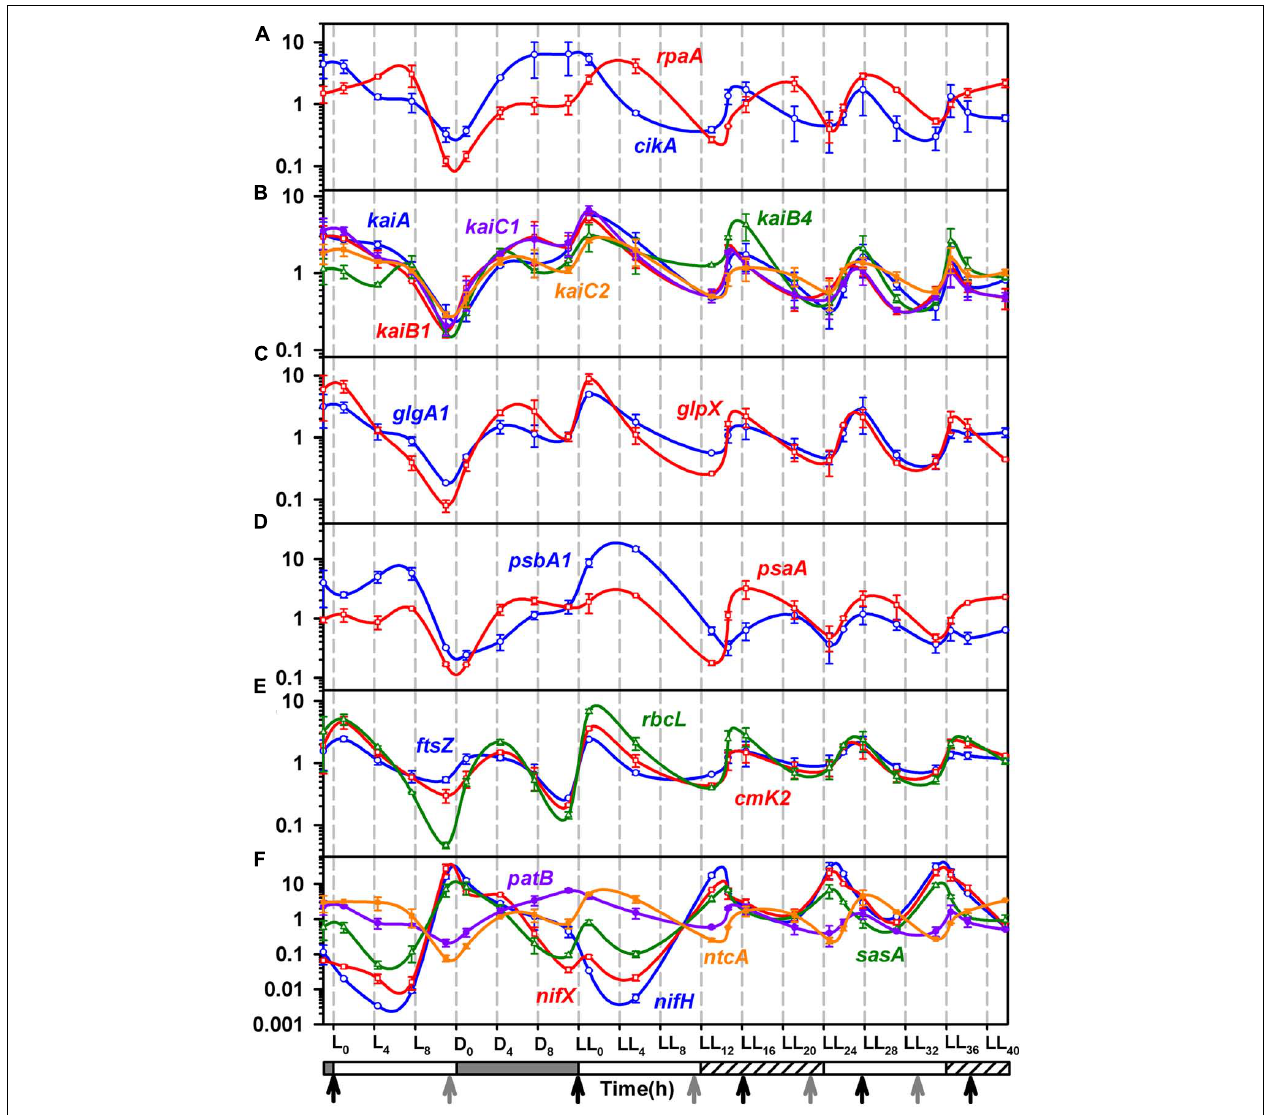
of glycogen synthesis with the clock. (D) The transcript profiles of psbA1 (blue) and psaA (red), genes of Photosystem I and II respectively; (E) The epxpression profiles of genes involved in carbon fixation, rbcL (green) and ccmK2 (red) and cell division, ftsZ (blue); (F) Transcription profiles of the circadian rhythm output pathway gene sasA (green) and genes of nitrogenase complex, nifH (blue) and nifX (red), nitrogen fixation regulation genes patB (violet) and ntcA (orange). Refer to Figure 1 for other details and Table 1 for details of genes and PCR